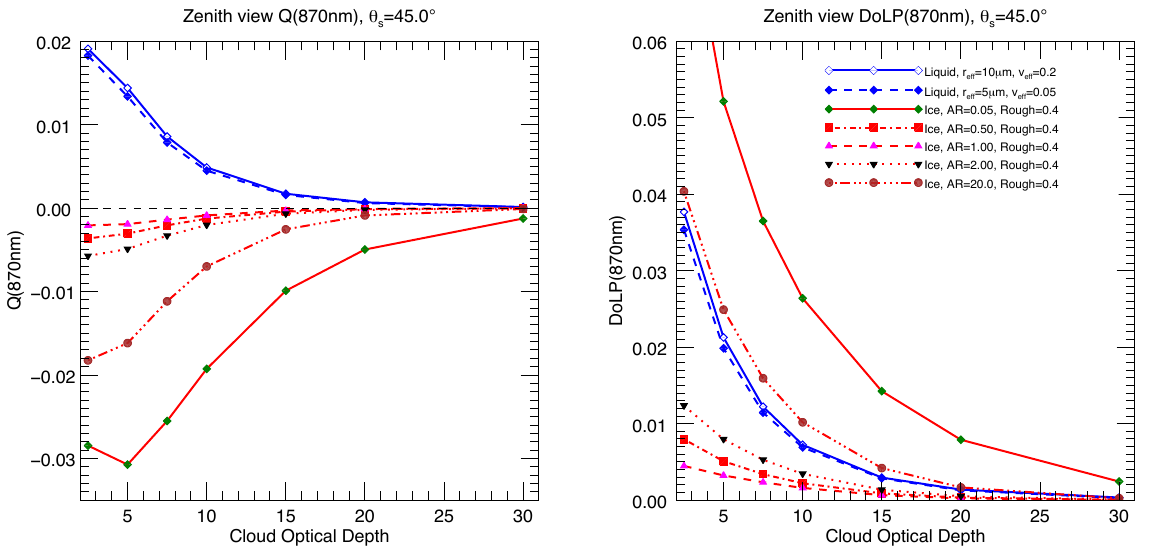
Figure 4. Simulated Q (left) and DoLP (right) for liquid (blue) and ice (red) phase clouds observed from the ground by a polarimeter observing in the zenith direction at 870nm and with a solar zenith angle of θ s = 45 ◦